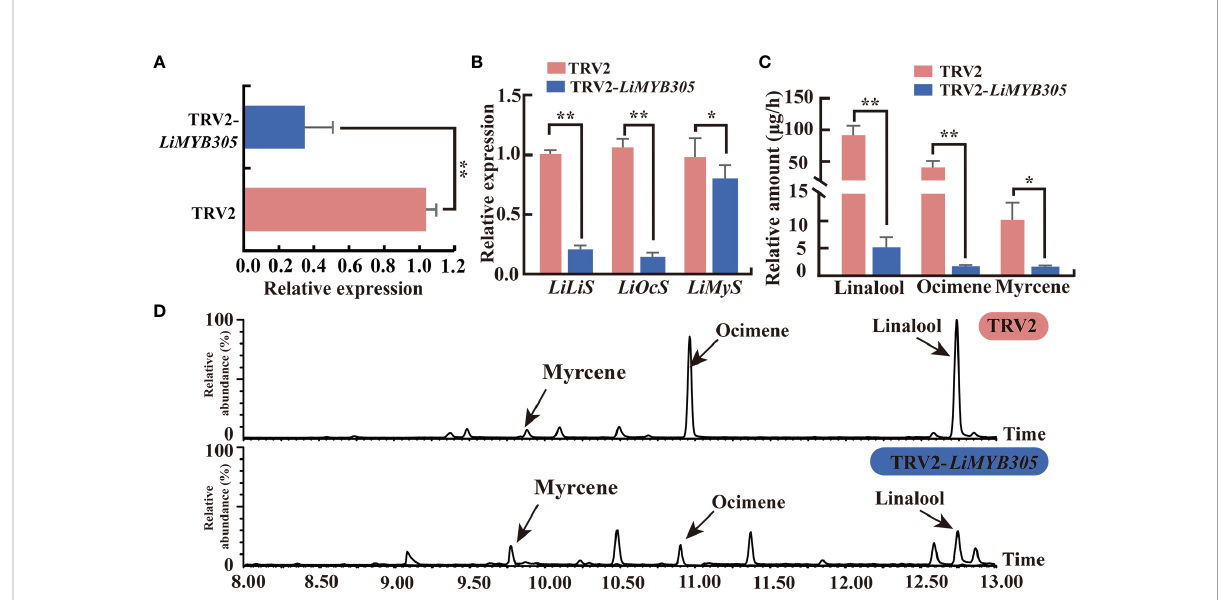
FIGURE 5 Effect of silencing LiMYB305 on three main monoterpenoids and gene expression levels. (A) qRT-PCR results of the LiMYB305 mRNA levels in TRV2- LiMYB305 petals compared with control pTRV2 petals. (B) qRT-PCR results of LiLiS , LiOcS , and LiMyS mRNA levels in petals of LiMYB305 - silenced plants compared with control plants. (C) Release of the three main monoterpenoids in petals of LiMYB305 silenced plants compared with control plants. (D) Total ion current (TIC) chromatograms of the fl ower fragrance compounds emitted from Lilium ‘ Siberia ’ . The peaks were myrcene, ocimene, and linalool, respectively. The fi rst column is the TIC of ‘ Siberia ’ infected with pNC-TRV2 (control), and the second column is the TIC of ‘ Siberia ’ infected with pNC-TRV2- LiMYB305. * P < 0.05, ** P < 0.01. Data are presented as mean ± SD, n =